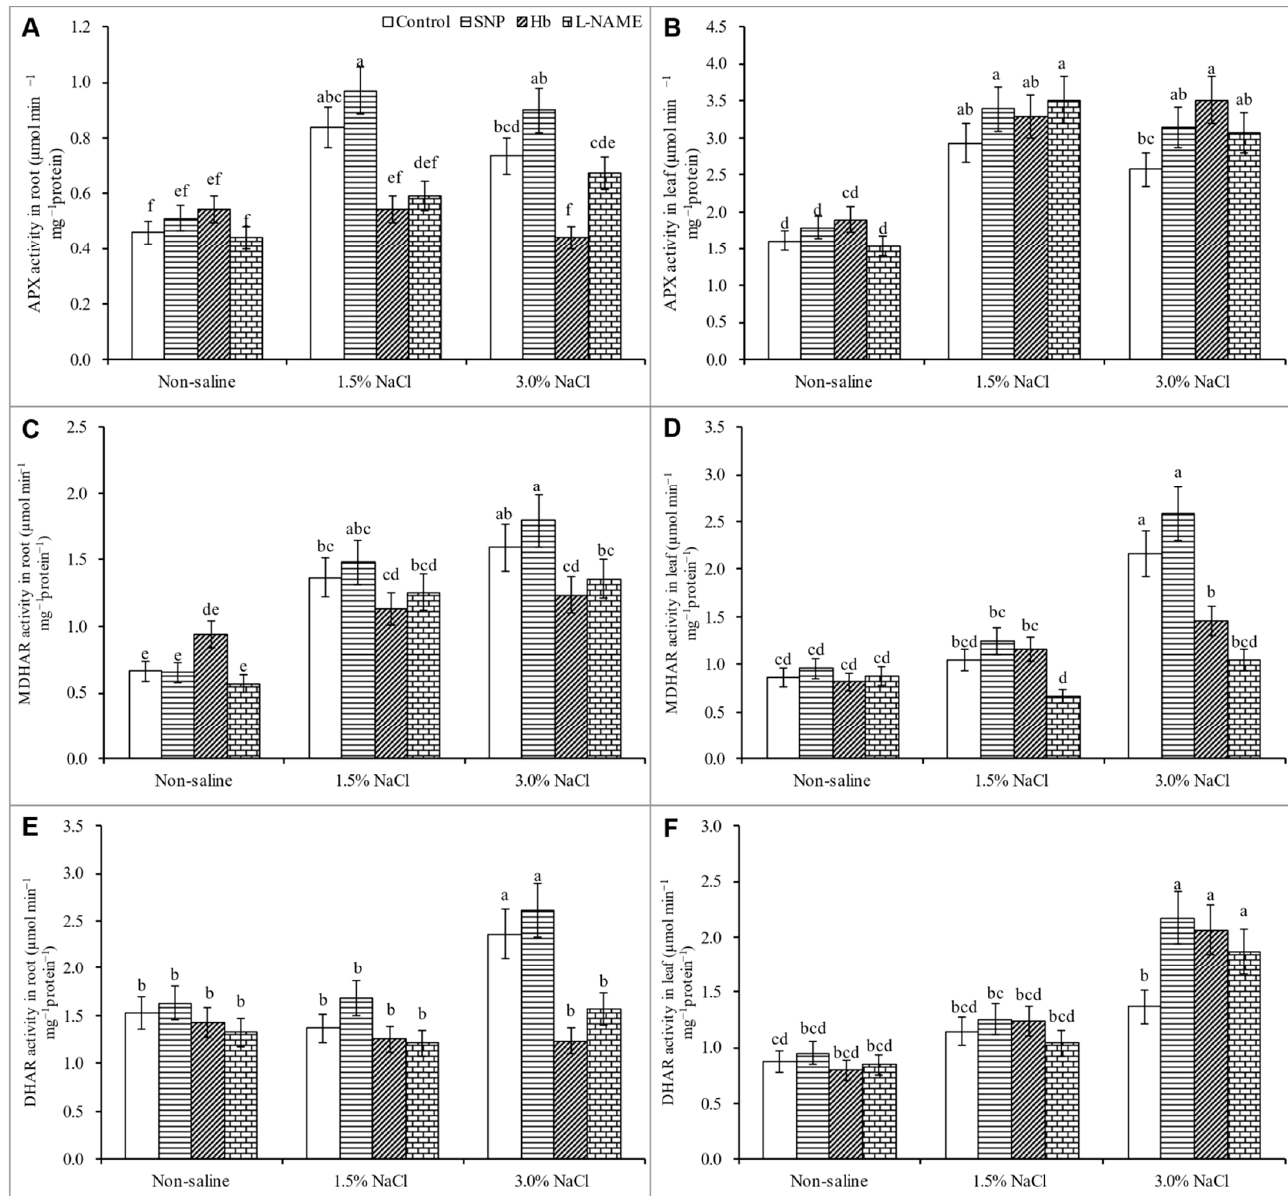
Figure 7. Activity of APX ( A , B ), MDHAR ( C , D ) and DHAR ( E , F ) in roots and leaves of Kandelia obovata treated with different salt concentrations and with 100 µM sodium nitroprusside (SNP, a NO donor), hemoglobin (Hb, a NO scavenger), or N ω -nitro- L -arginine methyl ester ( L -NAME, a NO synthase inhibitor). Mean (± SD) was calculated from three replicates for each treatment. Bars with different letters are significantly different at p ≤ 0.05, applying Tukey’s HSD test.